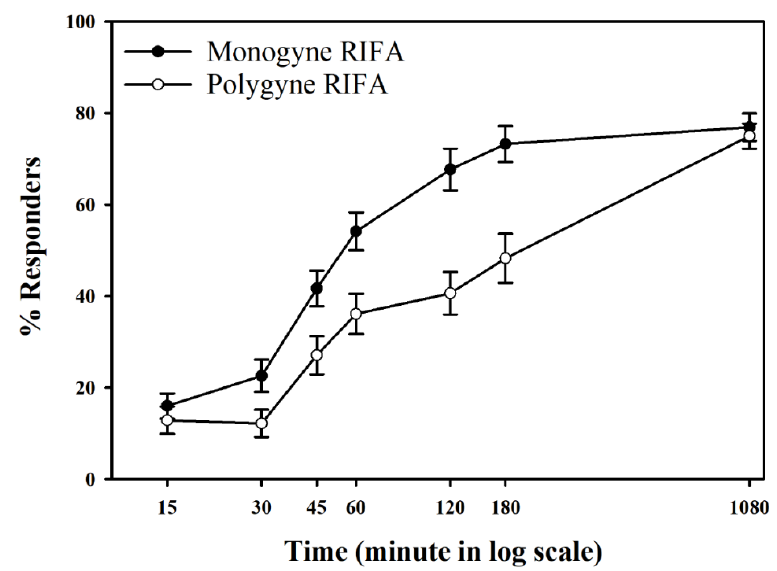
Figure 4. Monogyne and polygyne S. invicta responder percentages ( ± SE) in 2-choice bioassays at various time intervals. Each assay trial includes n = 6 worker ants; responders are located in/on treatment or control areas of bioassay arena; non-responders are in neutral areas (away from treatment and control).